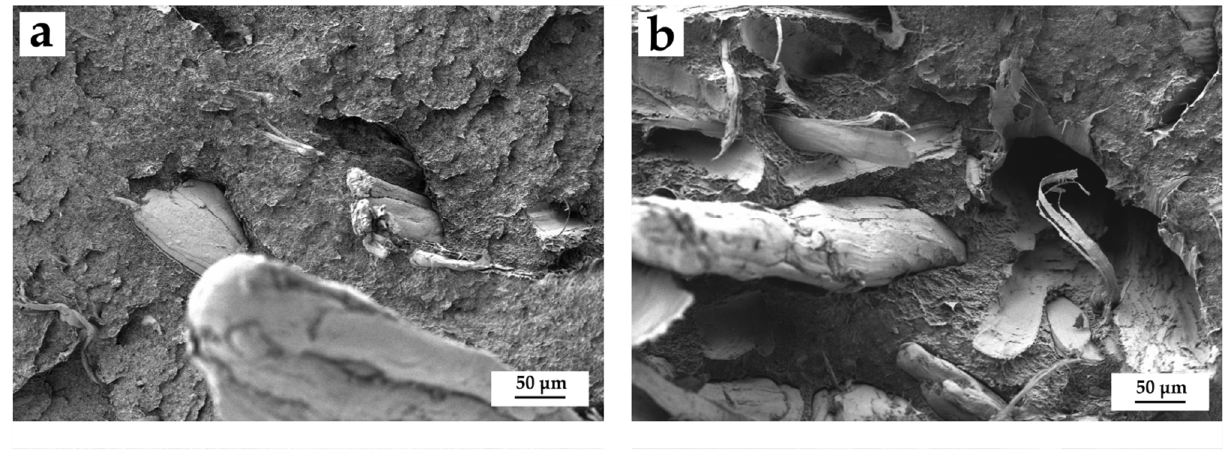
Figure 4. Comparative between Field emission scanning electron microscopy (FESEM) images at 250x of the comparison between composites with 20% HF with and without compatibilizers: ( a ) BioHDPE/20HF/PE-g-MA and ( b ) BioHDPE/20HF.